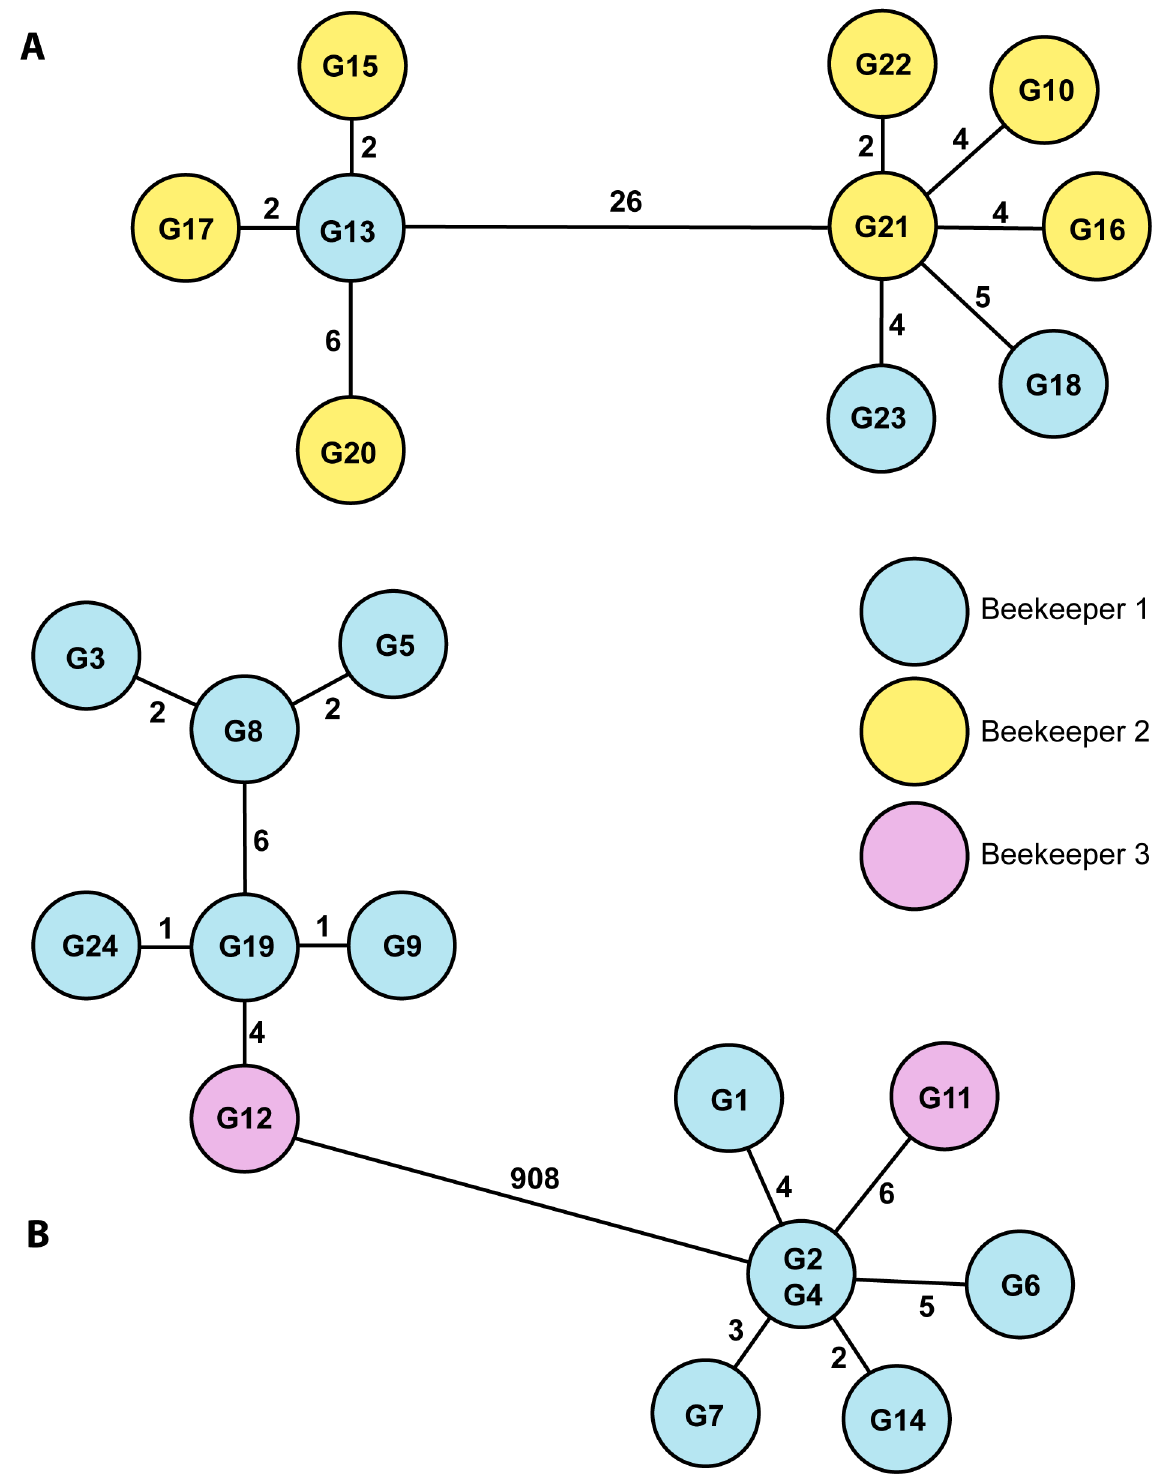
Fig 1. Core genome MLST results of Paenibacillus larvae isolates from the outbreak on Gotland in 2014. Two minimum spanning trees generatedin SeqSphere+ based on two cgMLST-analysis with ERIC II-isolates (A) and ERIC I-isolates (B), respectively. Results in A are based on 3,309 target genes and B is based on 3,155 target genes. The numbers represent the numberof alleledifferencesbetween isolates. The branch lengthsare not proportional to the number of differences. The colors indicatethe beekeeperorigin of the